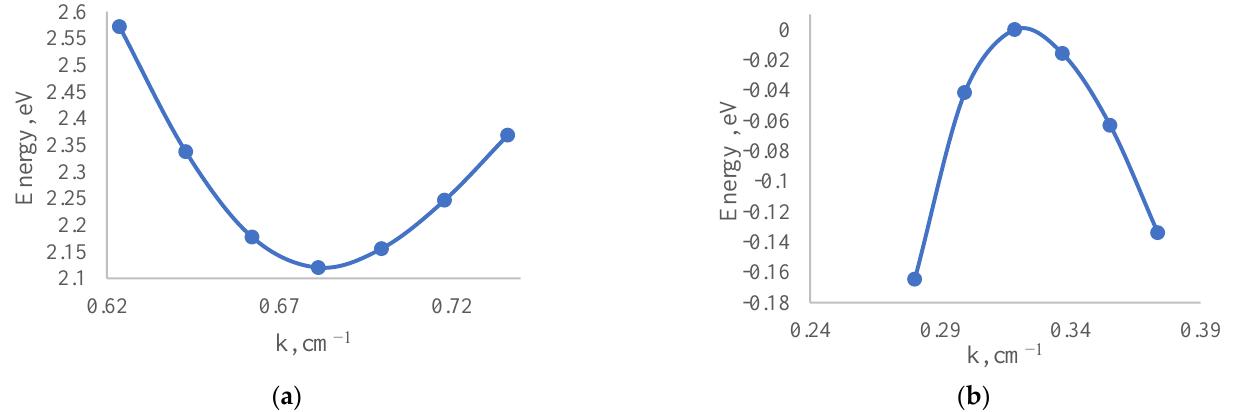
Figure 5. Band structure around the conduction band minima ( a ) and valence band maxima ( b ).